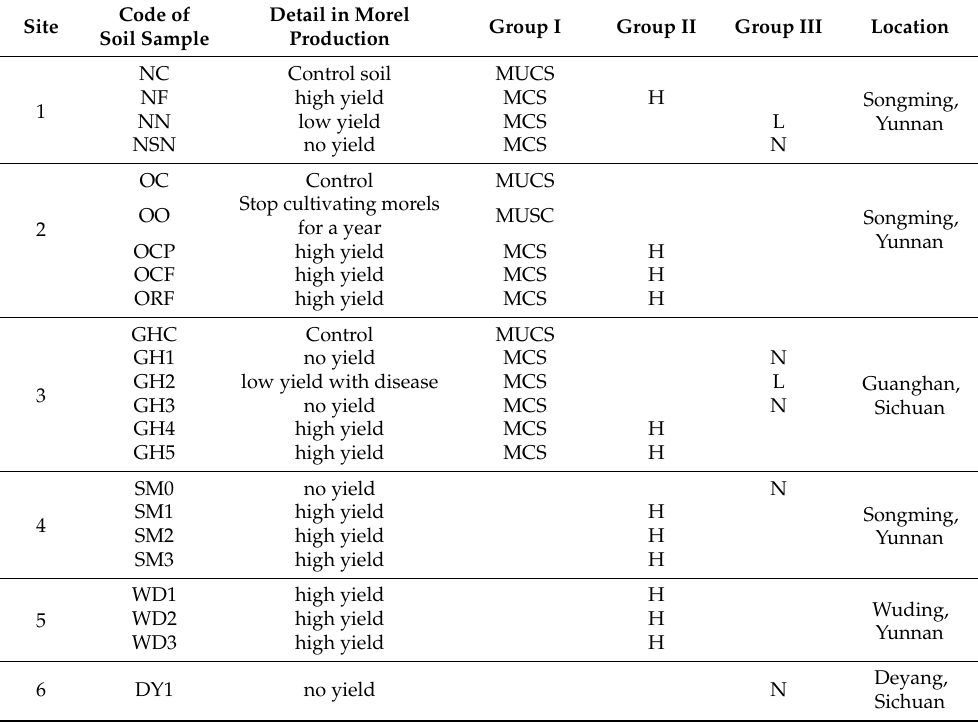
Table 1. Information of soil samples in this